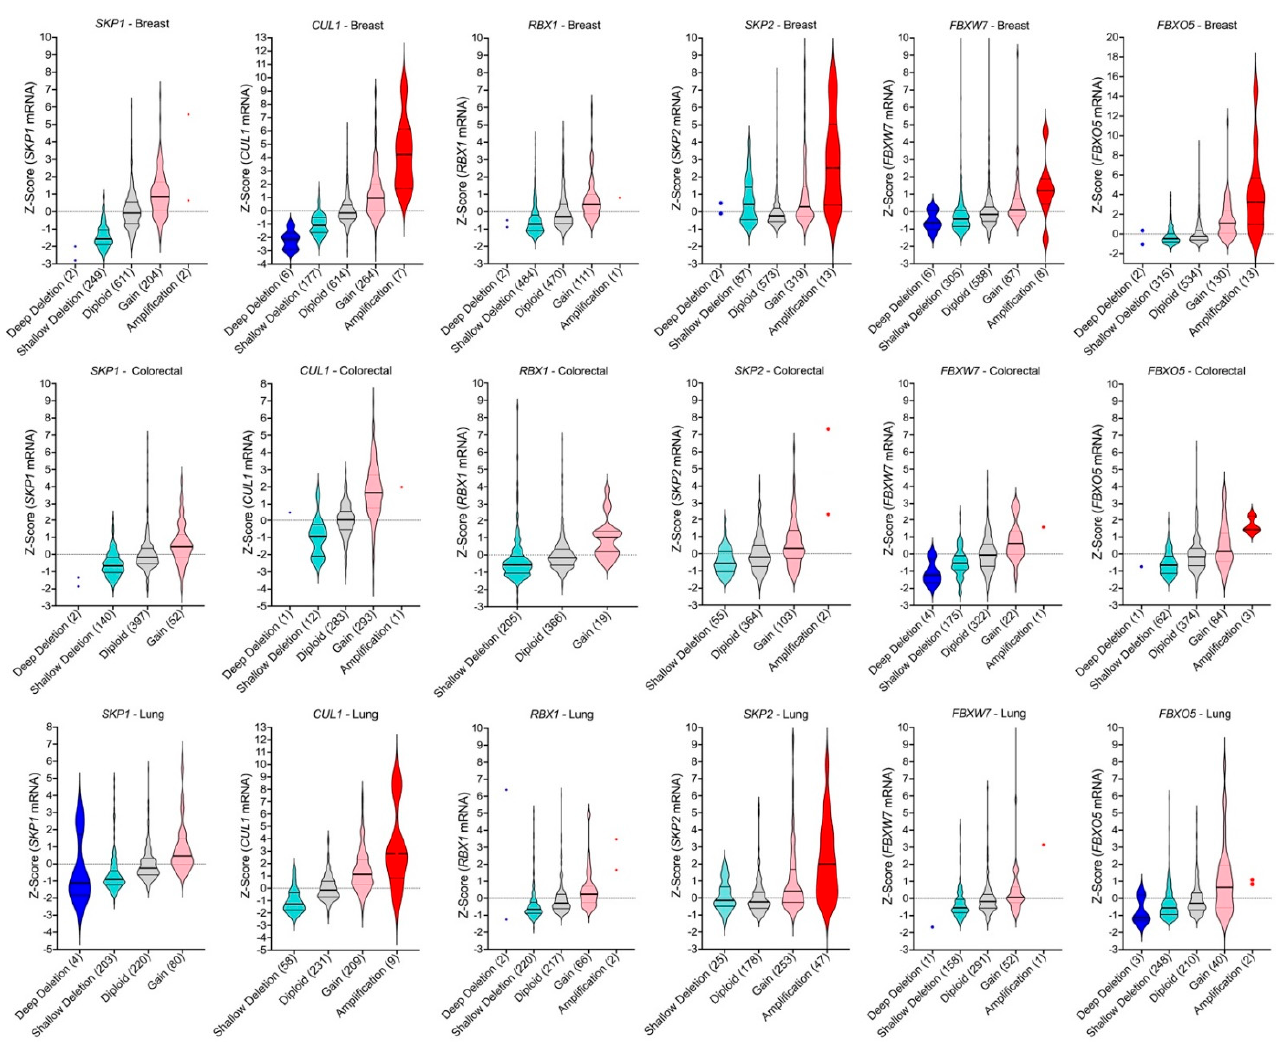
Figure 6. SCF complex copy number alterations correspond with changes in mRNA expression levels. Violin plots of mRNA expression data [35–37] from the three commonly diagnosed cancers (i.e., breast [top row], colorectal [middle] and lung [bottom]). SKP1 , CUL1 , RBX1 , SKP2 , FBXW7 , and FBXO5 CNAs (deep deletions; shallow deletions; gains, amplifications) and diploid cases are presented along the x -axis with total case numbers indicated within brackets. Note that categories with ≤ 2 cases are identified by dots and that in general, deep deletions, and amplifications are rare. Note that some of the y -axes are differentially scaled to better present the data.